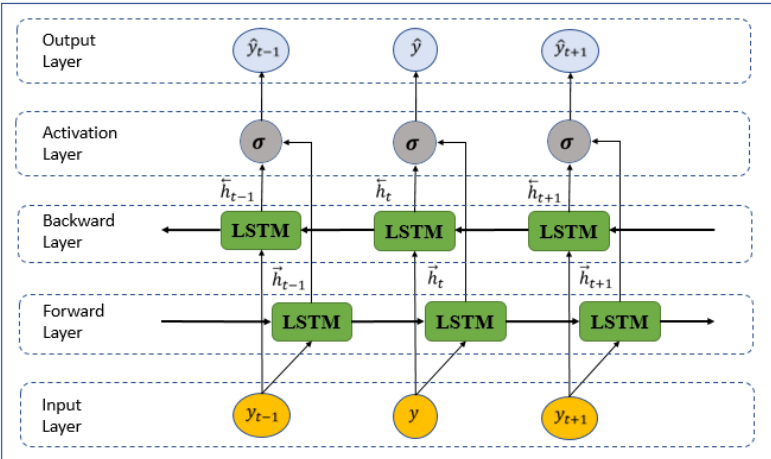
Figure 1. Model diagram for bidirectional LSTM